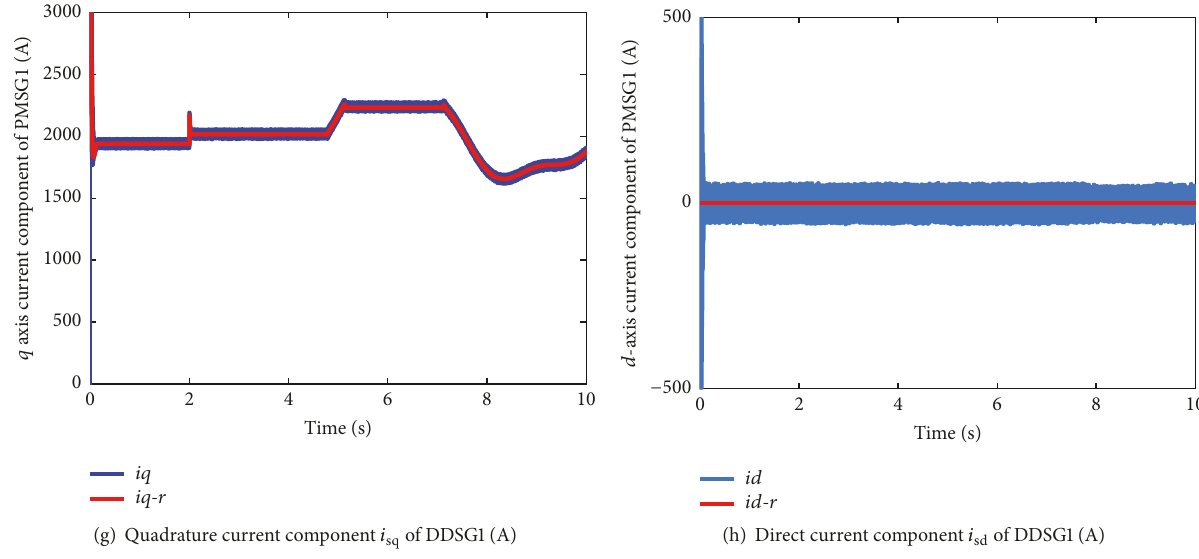
Figure 8: Simulation of the WFS in normal operation and using backstepping strategy.